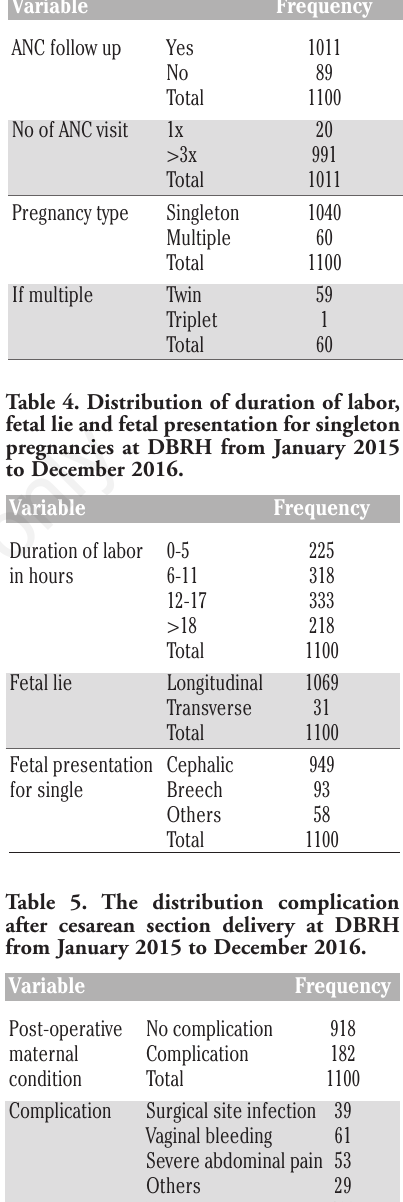
Table 2. Distribution of gravidity, parity and gestational age of mothers at DBRH